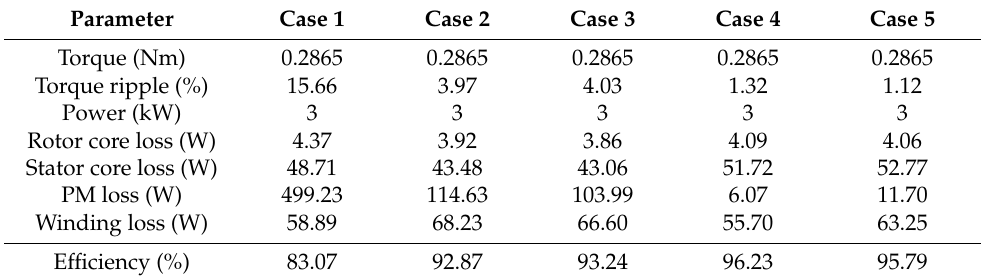
Table 4. 3D electromagnetic analysis for the considered